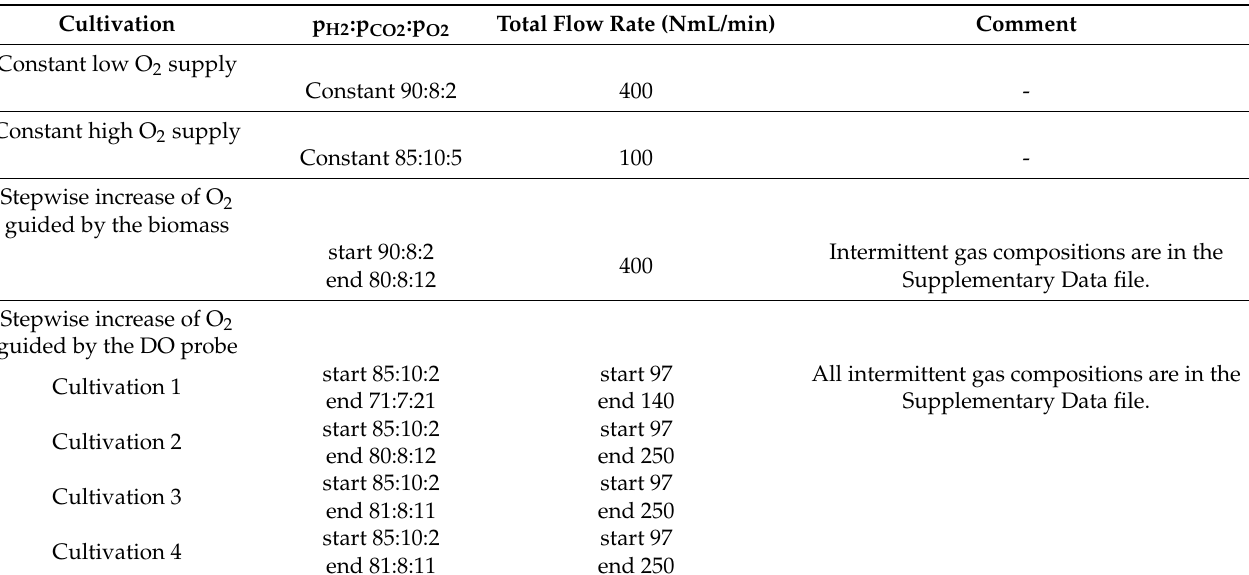
Table 2. Partial pressures of H 2 , CO 2 , O 2 , and total gas flows in individual gas